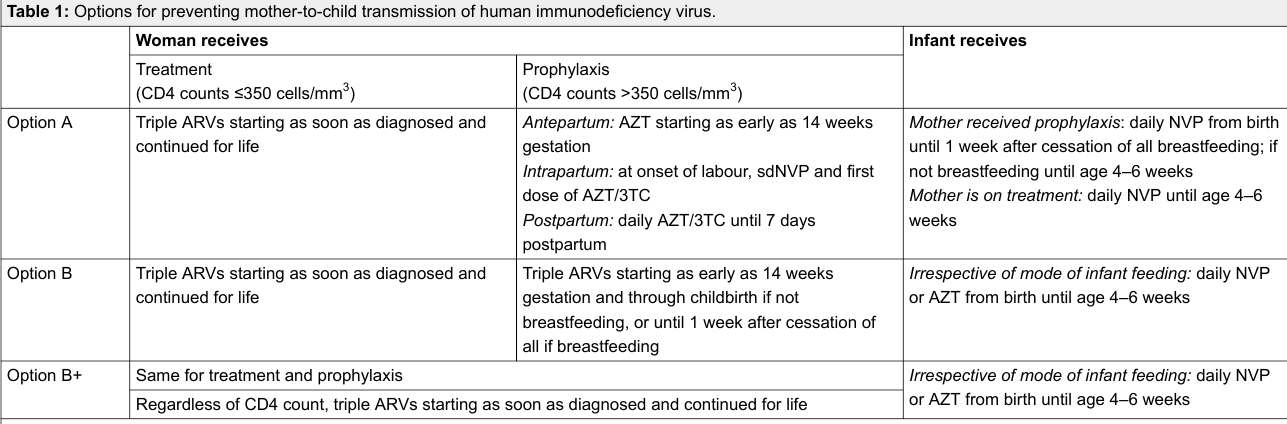
Infant receives